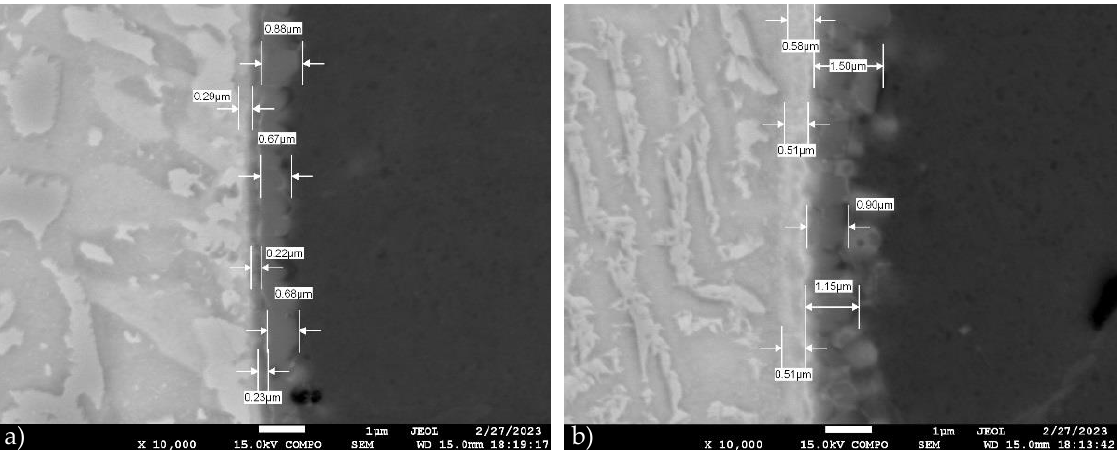
Figure 16. SEM images of Ti Grade 2 — weld metal interface for sample 7 taken from ( a ) the top and ( b ) the root part of the welded – brazed joint (laser power of 1800 W, welding speed of 25 mm·s −1 and laser beam offset of 460 μm).